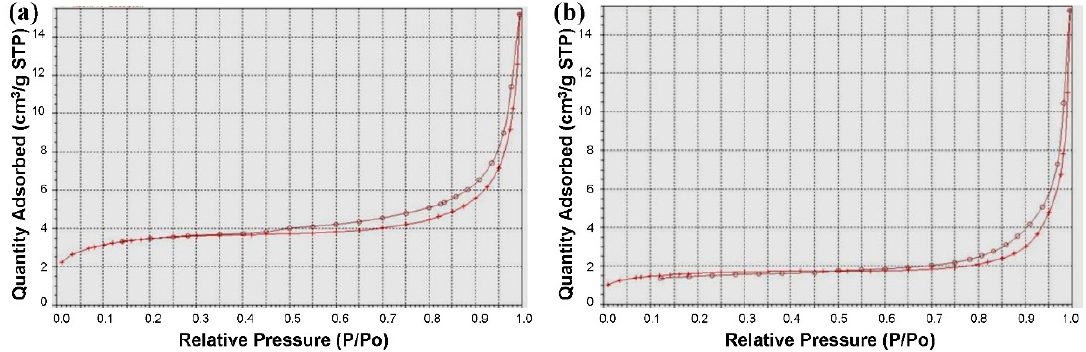
Figure 6. N 2 adsorption–desorption isotherm of ( a ) MBGNFs and ( b )